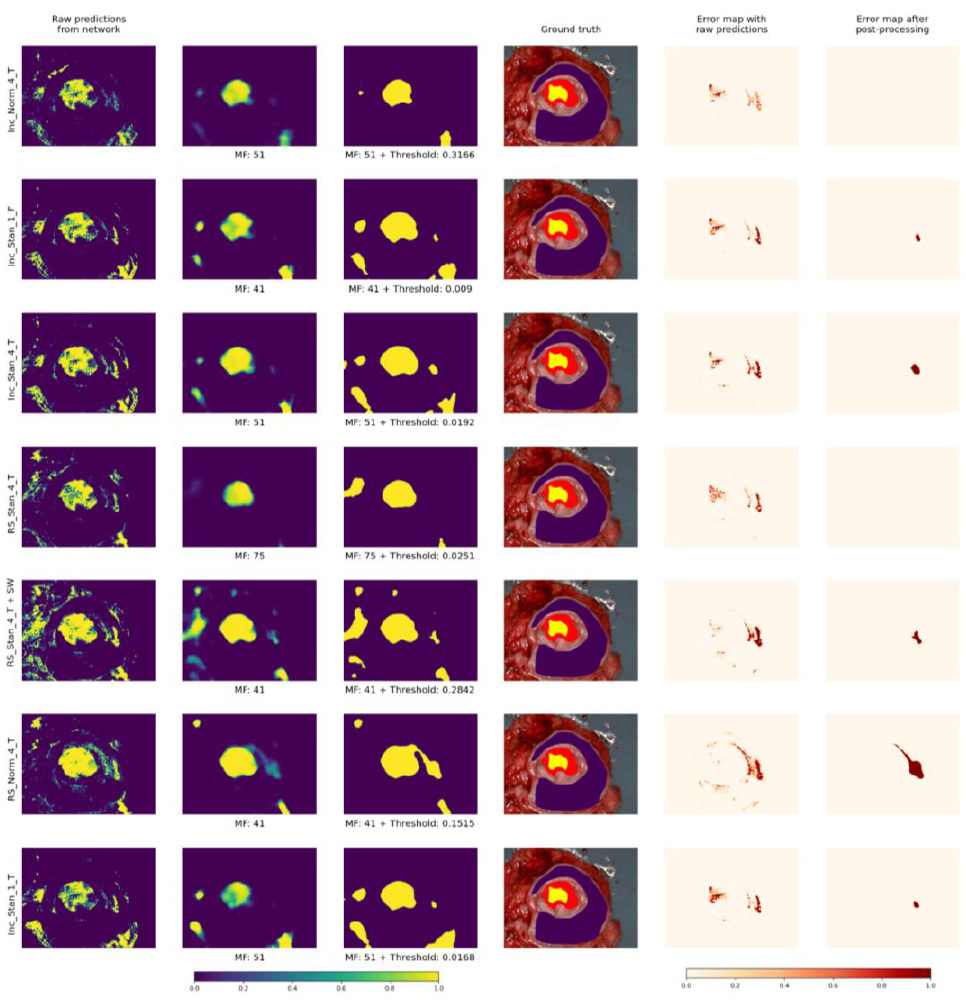
Figure 12. Visual results for one patient over all models with corresponding optimal parameters. Figure 14 depicts how different MF sizes and thresholds affect the output binary probability map. In the upper left corner is the original raw prediction map from the neural network. In the upper right corner is the ground truth mask. Images are ordered by MF size vertically, and by threshold horizontally. As it can be seen in each row, with an increasing threshold less area is recognized as cancerous, which is expected behavior, because fewer pixels fall under condition that the pixel’s probability is more than the threshold. Vertically, it can be seen that with increasing MF size, the detected areas are more packed, less fuzzy and less interspersed. All images in the figures are shown for model